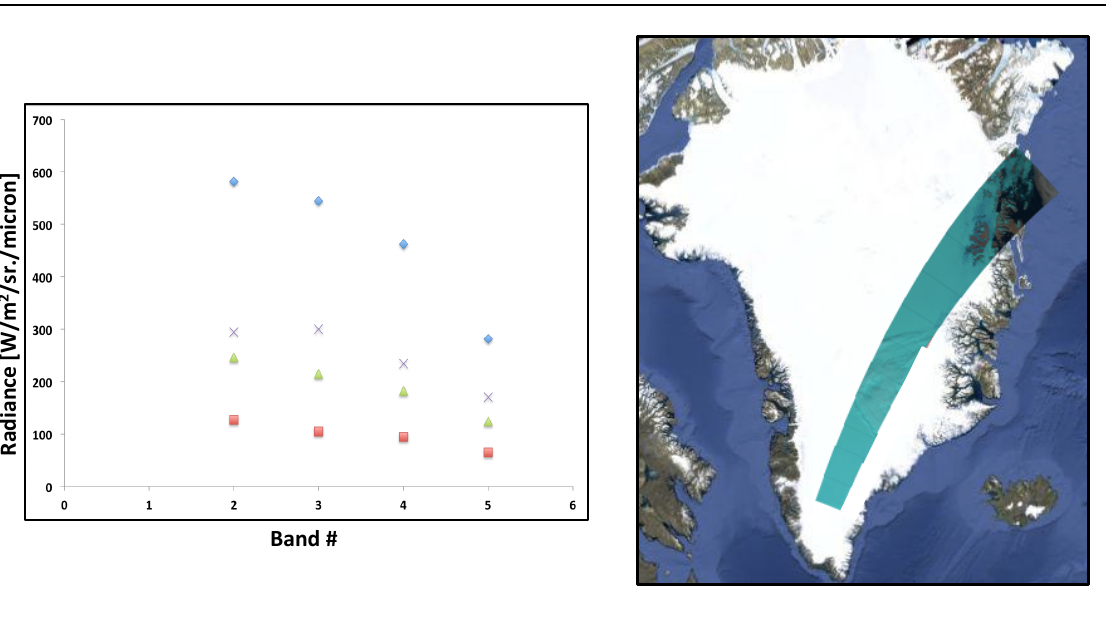
Figure 14. Figure illustrating a swath over Greenland ( right ) that is suitable for the side slither maneuver and the corresponding radiance levels observed in Landsat image data. The red squares show the minimum radiance levels and the green triangles show the maximum radiance levels observed in the Greenland test data. The purple x’s show the saturation levels for ETM+ while the blue diamonds show the saturation levels for